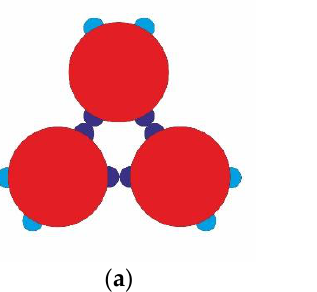
Figure 3. The two trimers which can be formed by PPs type I and type II: ( a ) trimer from PPs type I; ( b ) trimer formed by one PP type I and two PPs type II; Note that PPs type II cannot form solely a trimer.